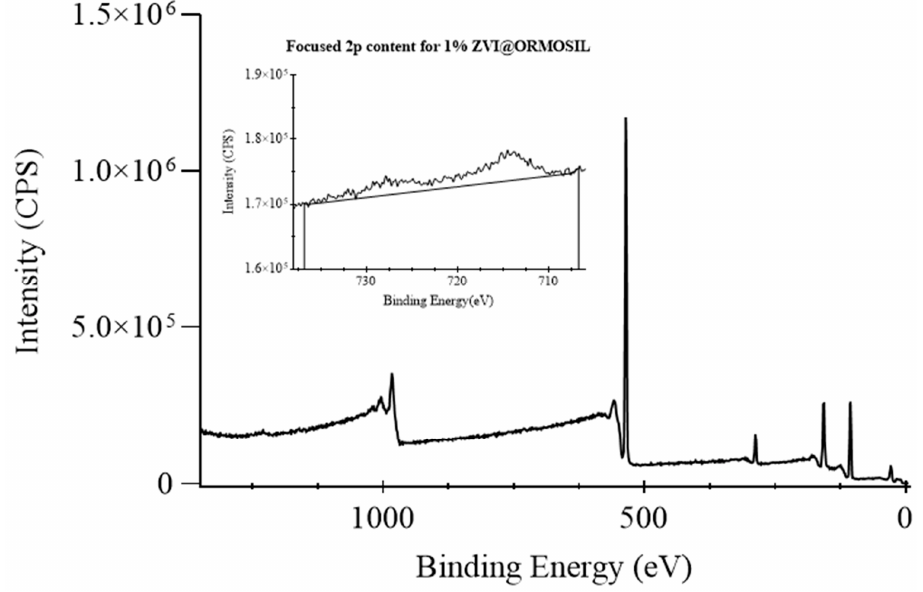
Figure 5. XPS spectra of 1.0% load ZVI@ORMOSIL. Insert: focused scan on Fe 0